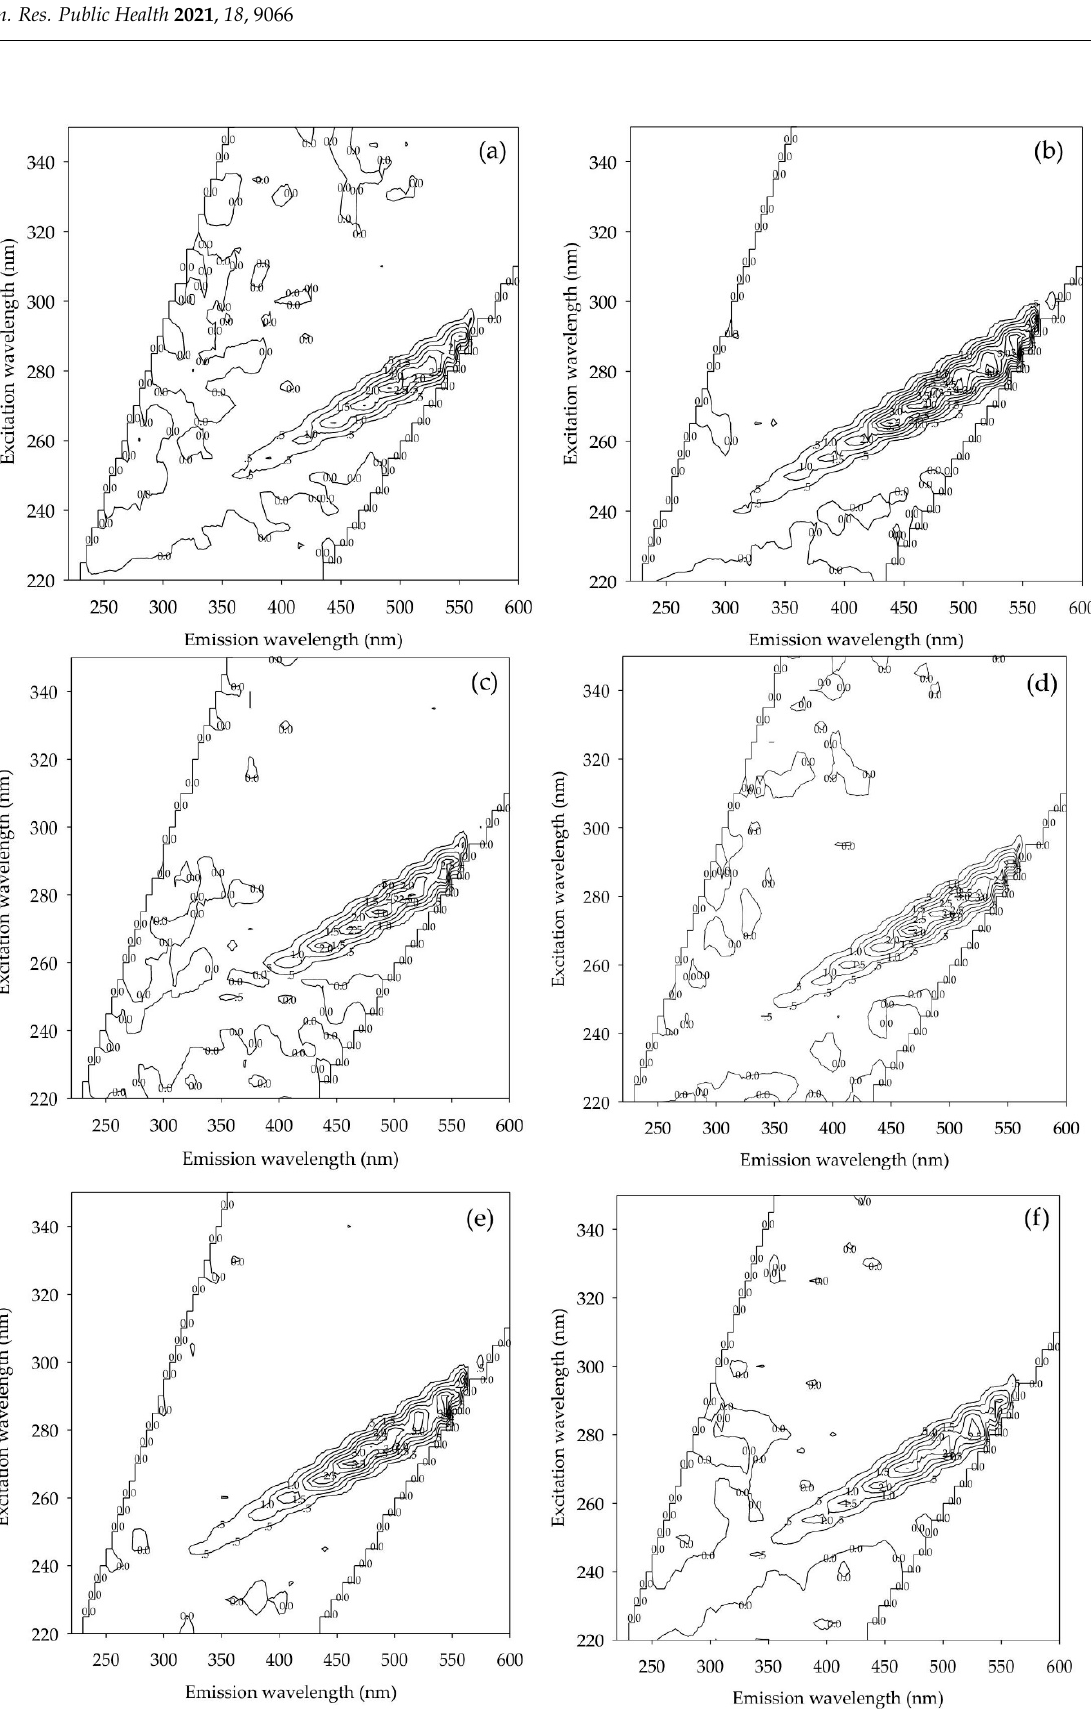
Figure 6. FEEM results of raw water, measured for six months: ( a ) September (2019), ( b ) October (2019), ( c ) November (2019), ( d ) December (2019), ( e ) January (2020), and ( f ) February (2020).